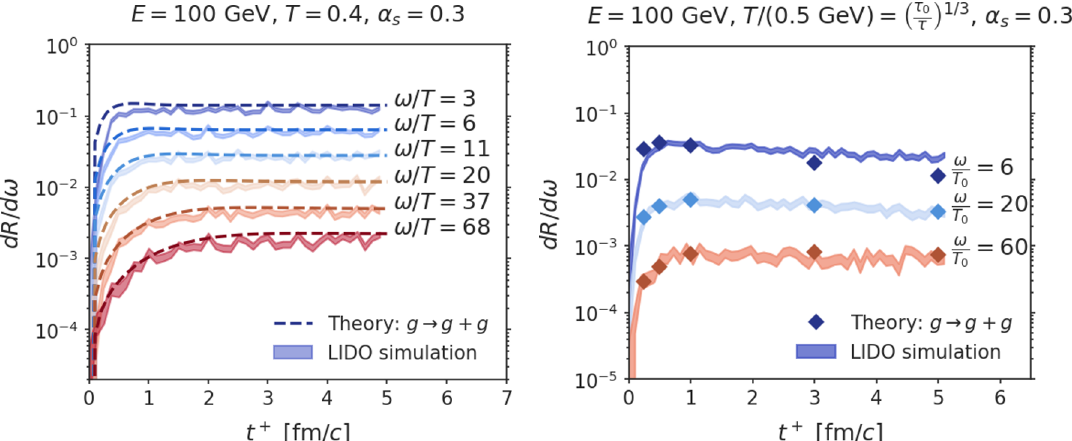
Figure 19 . Comparisons of the numerical solution of the full theory (dashed lines and symbols) [83] of the medium-induced single-emission rate of the process g → g + g to LIDO simulations (bands). Left: differential rate dR/dω in a static medium as a function of parton evolution time t + , plotted at different energy of the daughter gluon: ω/T = 3 , 6 , 11 , 20 , 37 , 68 . Right: differential rate dR/dω in an expanding medium as a function of parton evolution time t + , plotted at different energies of the daughter gluon: ω/T = 6 , 20 , 60 . The medium expands according to Bjorken flow where T 3 ∝ τ − 1